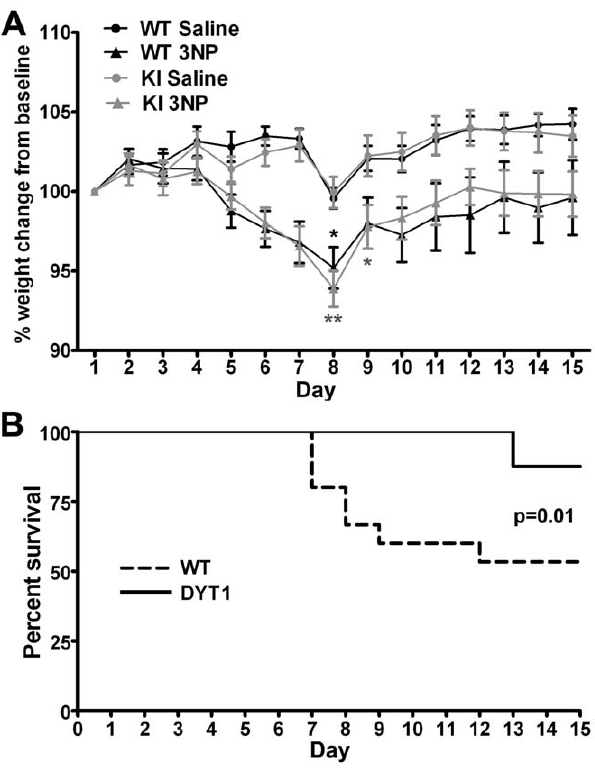
Figure 2. DYT1 KI mice are resistant to death caused by 3-NP. (A) Change in weight during the injection period expressed as a percentage of the initial weight. Two way ANOVA for repeated measures demonstrates a significant interaction between time and experimental group ( F [42,630]=3.34; p , 0.0001). Post-test Bonferroni was done using the WT Saline group as a reference (*p , 0.05; **p , 0.01). (B) Kaplan Meyer survival curve for DYT1 and control mice demonstrates statistically significant differences in mortality upon treatment with 3-NP between both genotypes. The Gehan-Breslow- Wilcoxon test was used for statistical analysis. All animals that received saline survived. There was no mortality beyond the injection period.